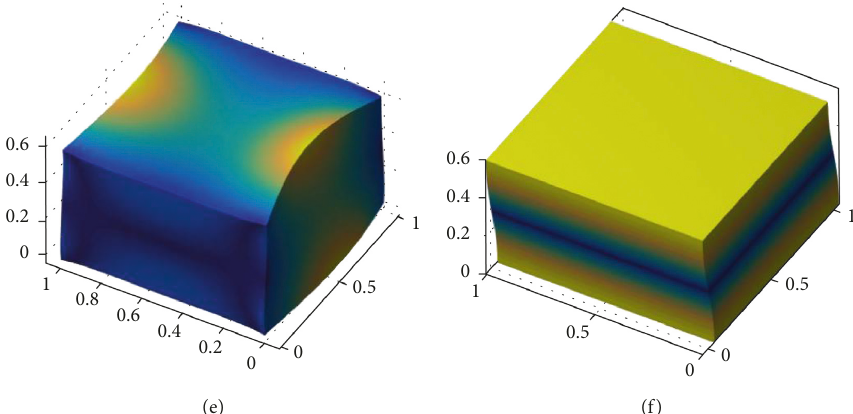
Figure 8: Mode shapes of orthotropic rectangular plates with the SFSF boundary condition: (a) 1st mode; (b) 2nd mode; (c) 3rd mode; (d) 4th mode; (e) 5th mode; (f) 6th